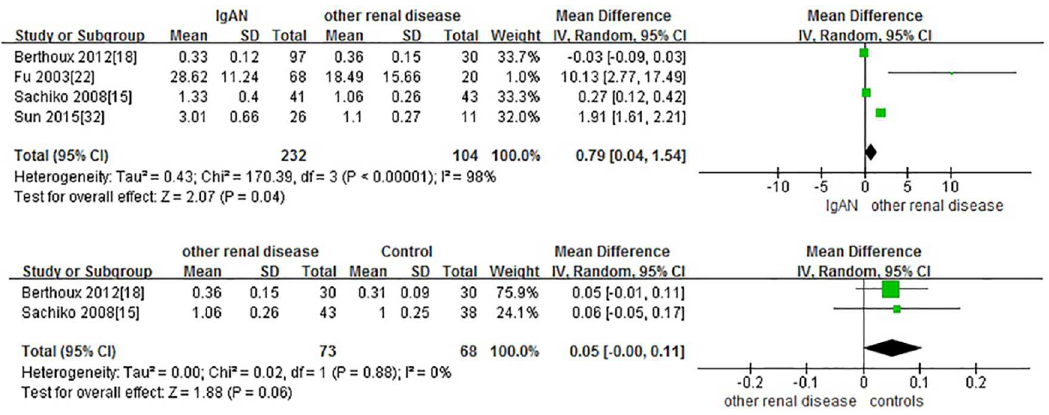
Fig 5. The forest plots of IgAN group and other renal disease